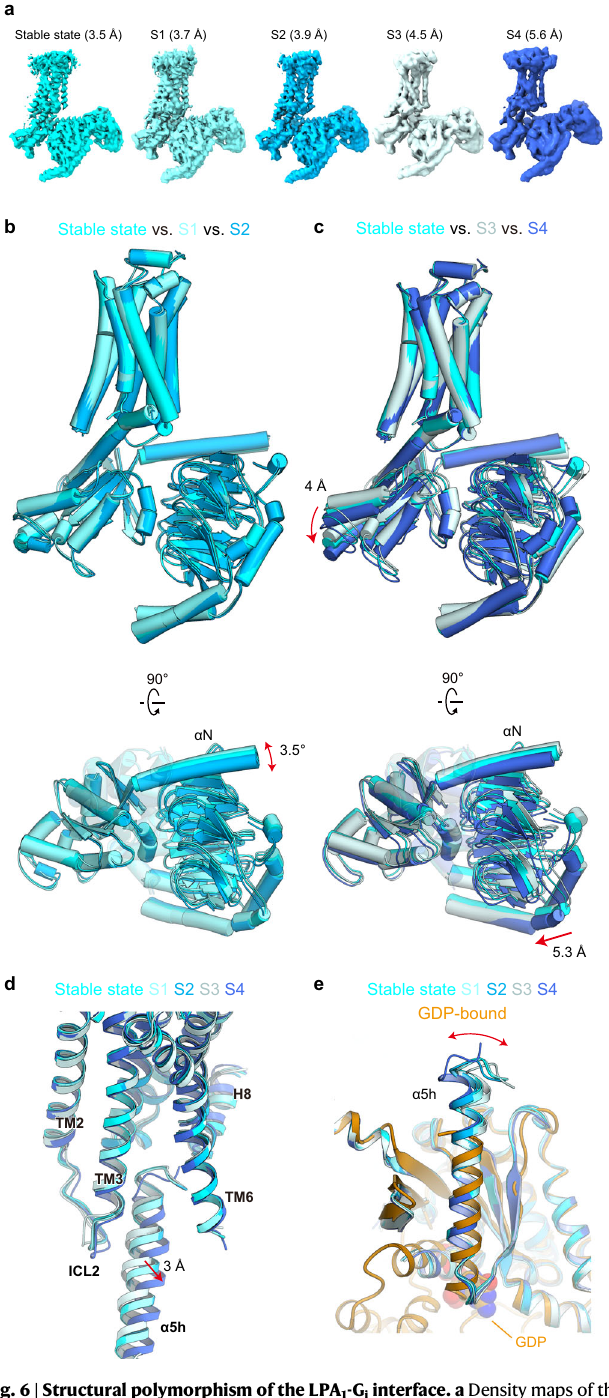
Fig. 6 | Structural polymorphism ofthe LPA 1 -G i interface.a Density maps of the 3.5Å resolution stablestate and S1 – 4. b Comparison of the stable state, S1, and S2. c Comparison of the stable state, S3, and S4. d Superimposition of the stable state and S1 – 4, aligned at the receptor. TM5 is omitted. e Superimposition of the G α i1 subunits in the stable state, S1 – 4, and the GDP-bound inactive G i heterotrimer (PDB